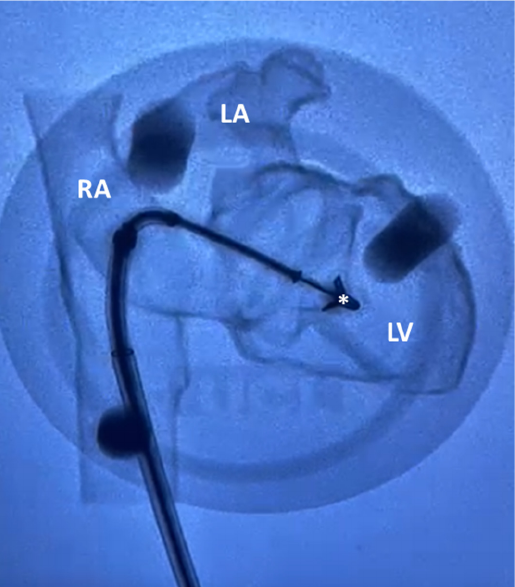
Figure 7. The 3D printed simulator, with deployed CDS, visualised under fluoroscopic imaging. Left atrium (LA), left ventricle (LV), right atrium (RA) and the clip (*) are labelled.